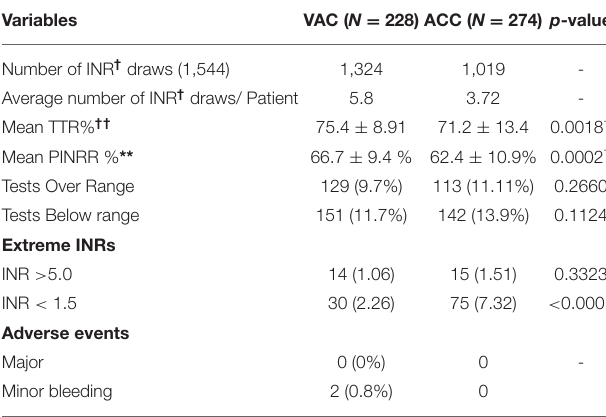
TABLE 1 | Patient characteristics and anticoagulation related parameters. TABLE 2 | Anticoagulation related Quality